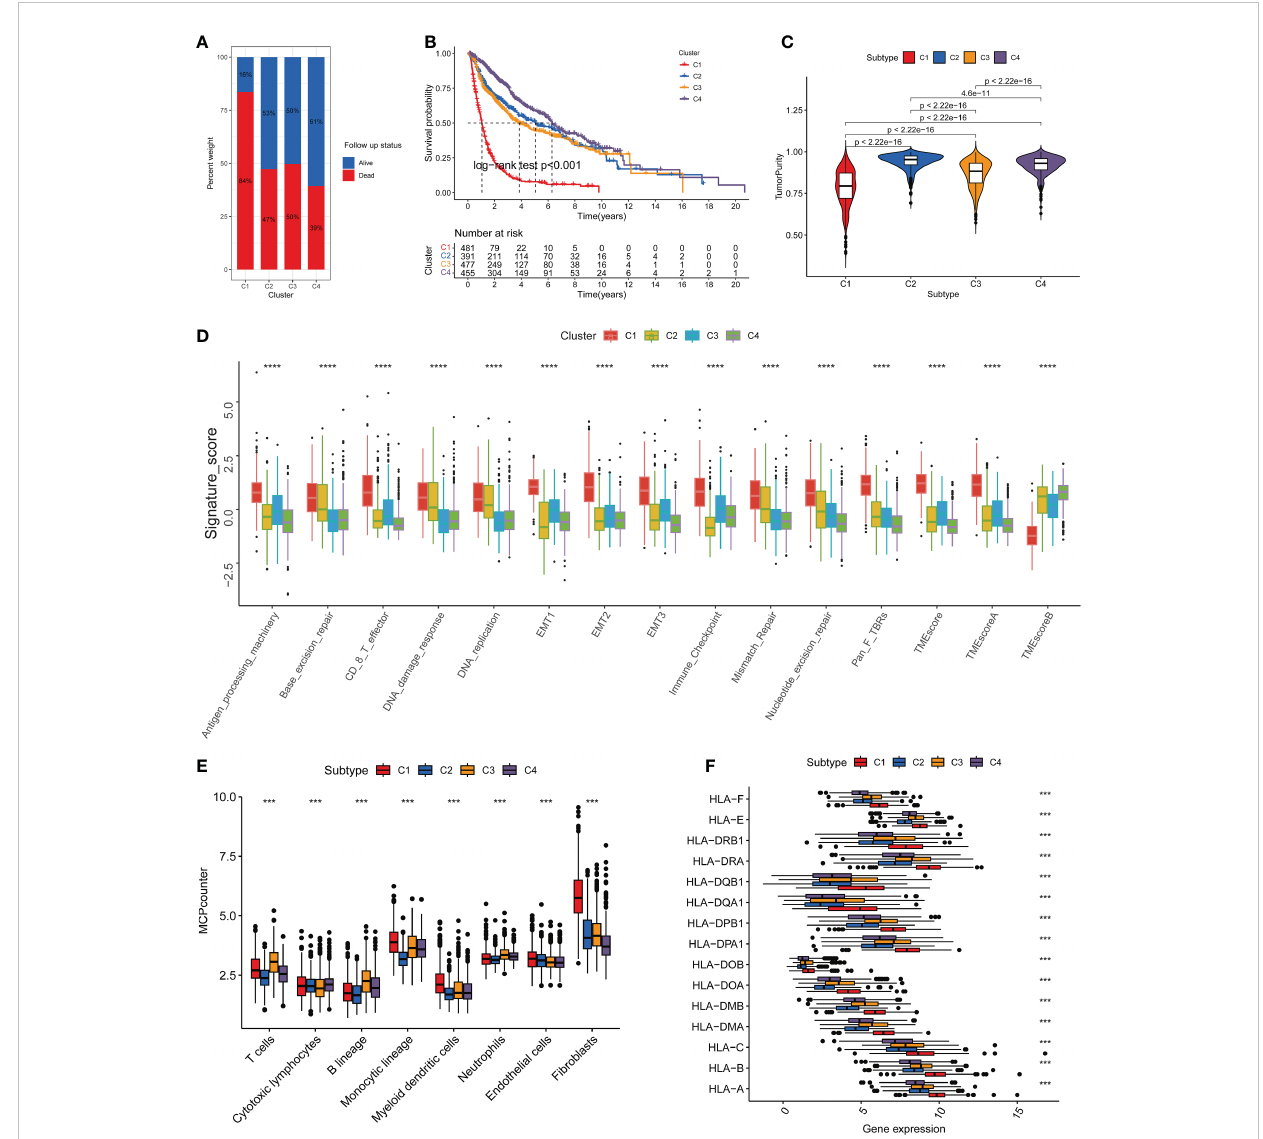
FIGURE 3 Discrimination of Different Subtypes. (A) The proportion of survival status of patients in four transmembrane protein-related subtypes. (B) Kaplan – Meier survival analysis of OS for patients with the four transmembrane protein-related subtypes. (C) Comparisons between the four subgroups in terms of tumor purity in tumor tissues. (D) Boxplots were used to display the expressions difference of tumor microenvironment signature. (E) Comparison of the abundance of immune-in fi ltrating cells among the four subgroups by the MCP-counter algorithm in tumor tissues. (F) Boxplots were used to display the expressions difference of HLA genes. ∗∗∗ P < 0.001; ∗∗∗∗ p < 0.0001. Survival analysis was conducted using the Kaplan-Meier method. Figure 2C adopted the Wilcoxon test method. Other Differential analyses were conducted using the Kruskal-Wallis